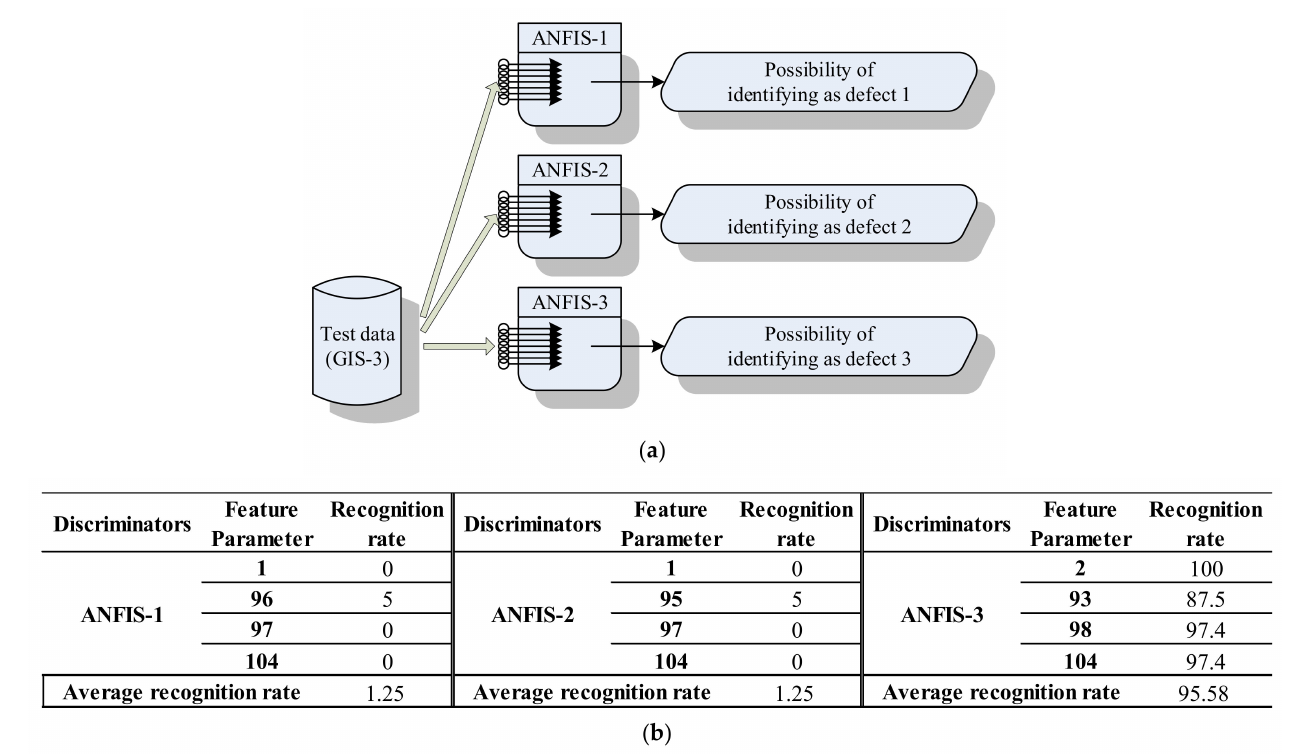
Figure 41. GIS-3 in parallel recognition system: ( a ) test architecture; ( b ) test